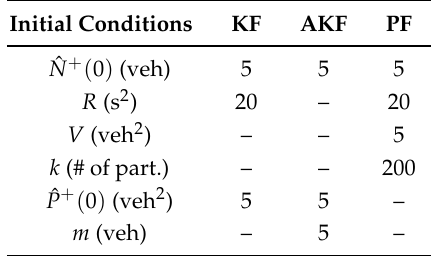
Table 1. Initial conditions for the Kalman filter (KF), adaptive KF (AKF), and particle filter (PF)